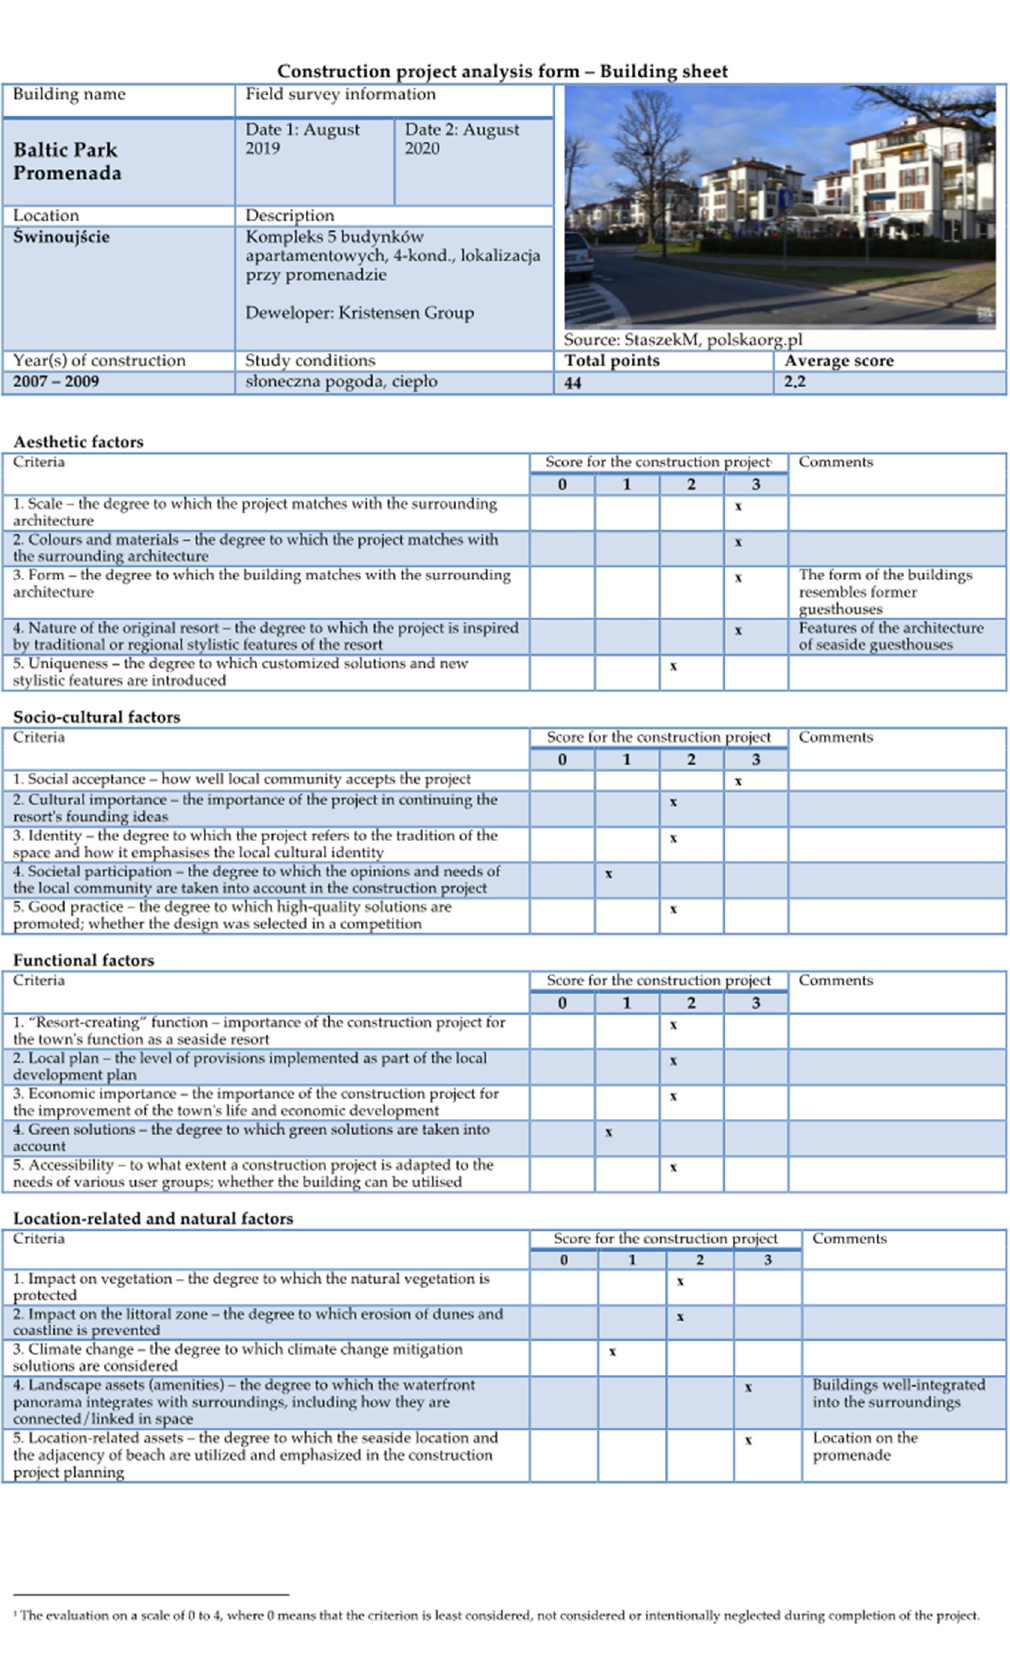
Figure A4. Baltic Park Promenada in Ś winouj ś cie. Building sheet.